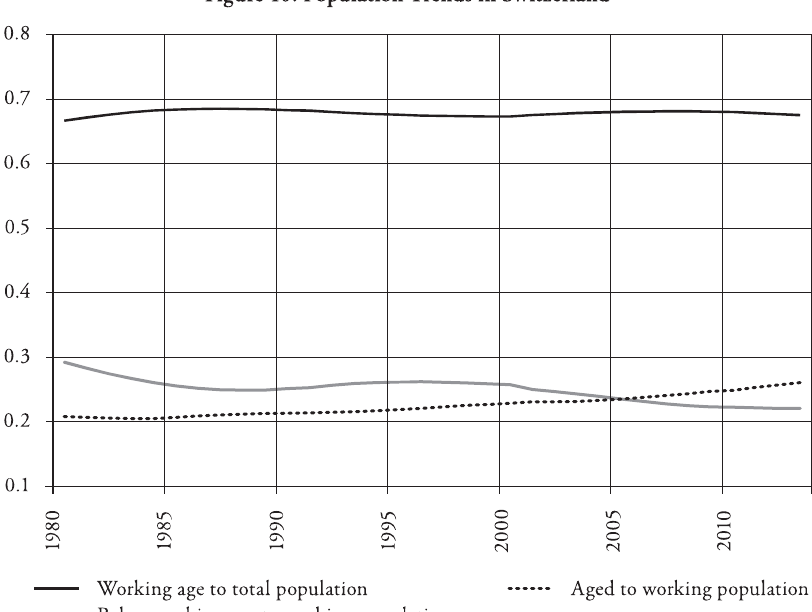
Figure 10: Population Trends in